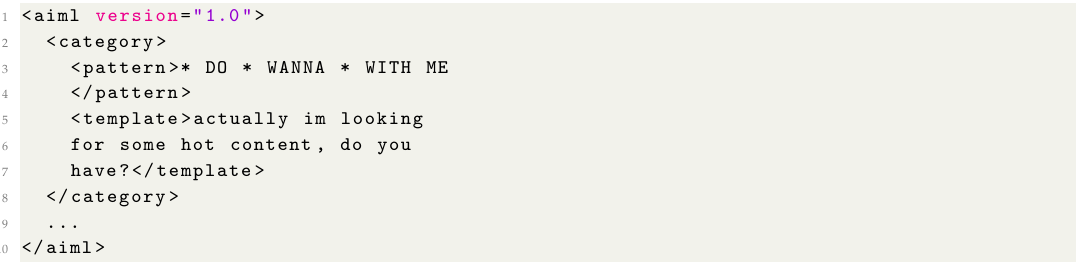
Table 2. Example of replies from the generative model of C 3